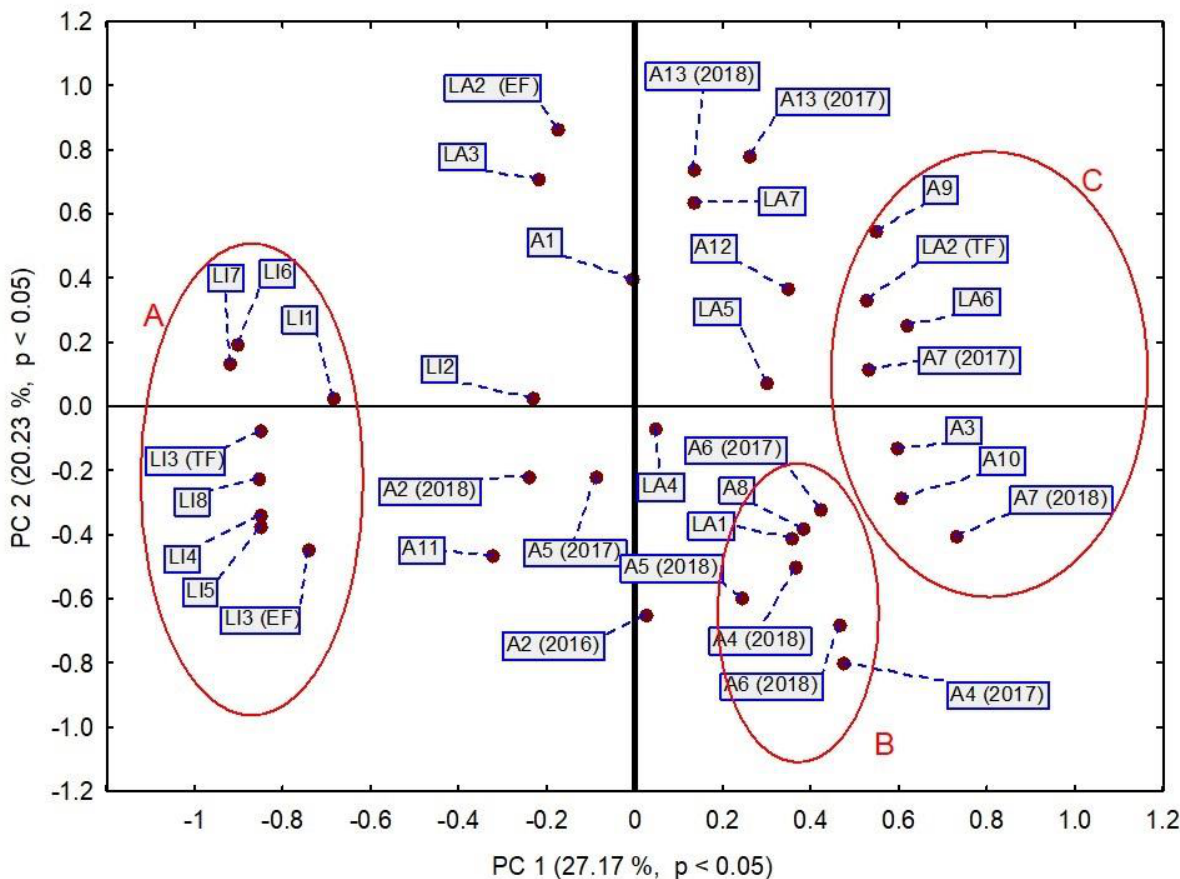
Figure 5. PCA score plot of all obtained data based on average content of EO components in different cultivars. PC — principal component.